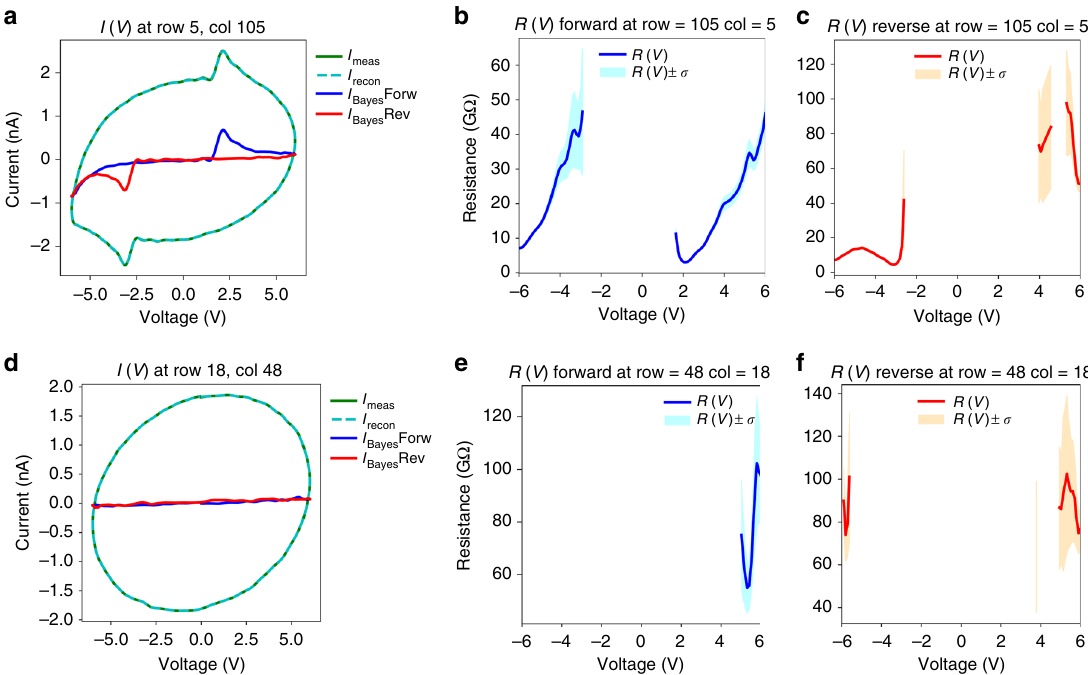
Fig. 3 Bayesian inference for G-IV. a , d I – V curves measured on the nanocapacitor ( a ) and the bare fi lm ( d ) via the G-IV method. The measured current is plotted as I meas , and the current is reconstructed via the Bayesian inference of the capacitance and resistance pro fi les ( I recon ). The curves without the circuit (capacitance and a 0 C ) contributions are plotted as solid blue and red lines for the forward and reverse traces, respectively. The inferred R ( V ) pro fi les are shown in b , c and e , f for the two cases ( a , d ), for both forward and reverse traces, and are plotted along with their standard deviation (colored